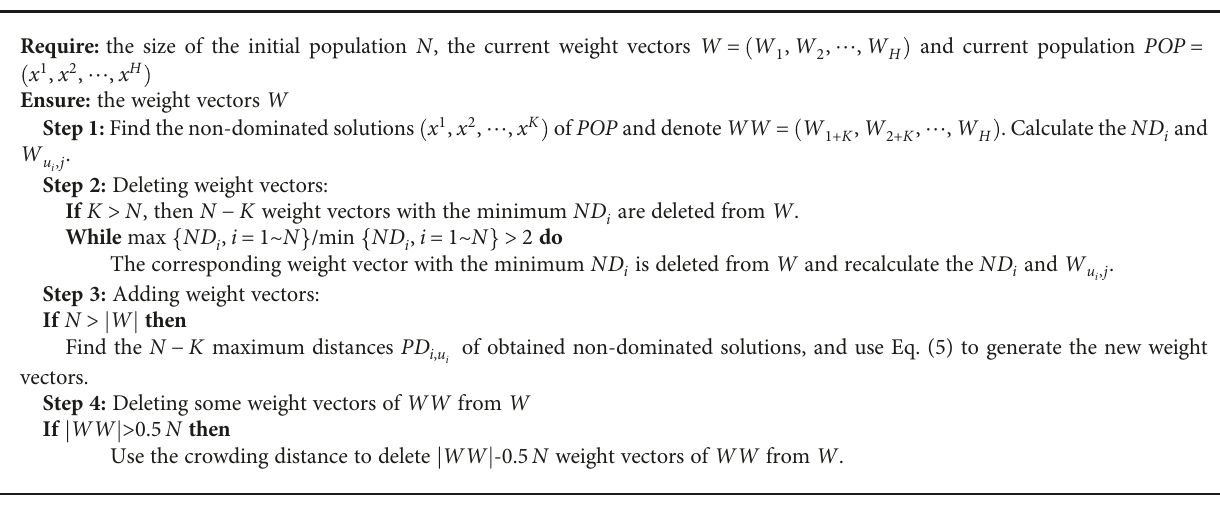
Figure 2: The adaptive weight vector adjustment. Assume, N = 6 , a , b , … , i are the current optimal solutions of the corresponding subproblem of the weigh vectors W , W , … , W , respectively. (a) Deleting strategy: b and g are the dominated solutions, and W 1 2 9 W are fi rstly deleted; K = 7 > N , d is the most crowded solution, and W 8 , W , W , and W are fi rstly deleted; K = 5 < N , i is the thinnest solution, W solutions, and W 2 4 7 8